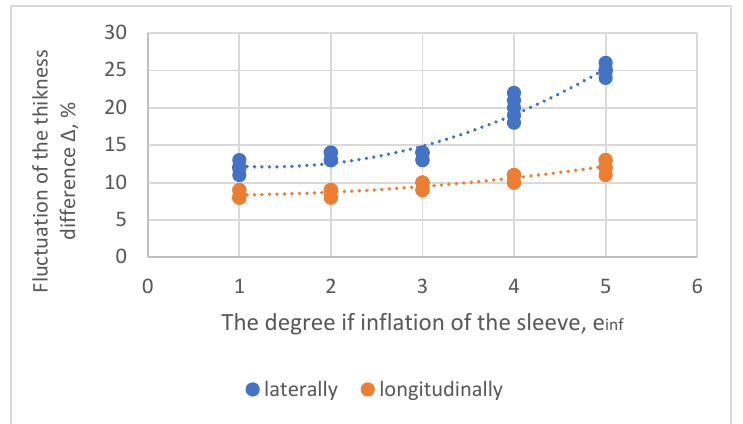
Figure 20. Dependence of fluctuations in the average thickness (thickness difference) of the film and degree of inflation of the sleeve.